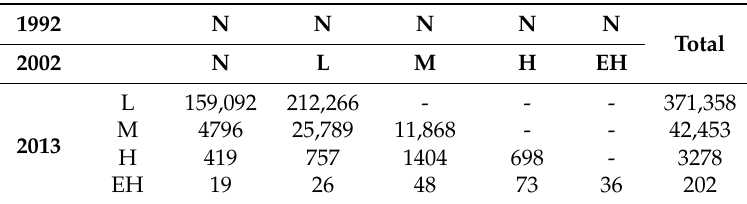
Table 2. Pixel count of transition types for areas lit after 1992 across Southeast Asian countries between 1992, 2002, and 2013. 1992 N N